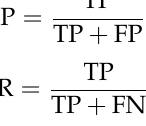
Figure 5. Sample images from the